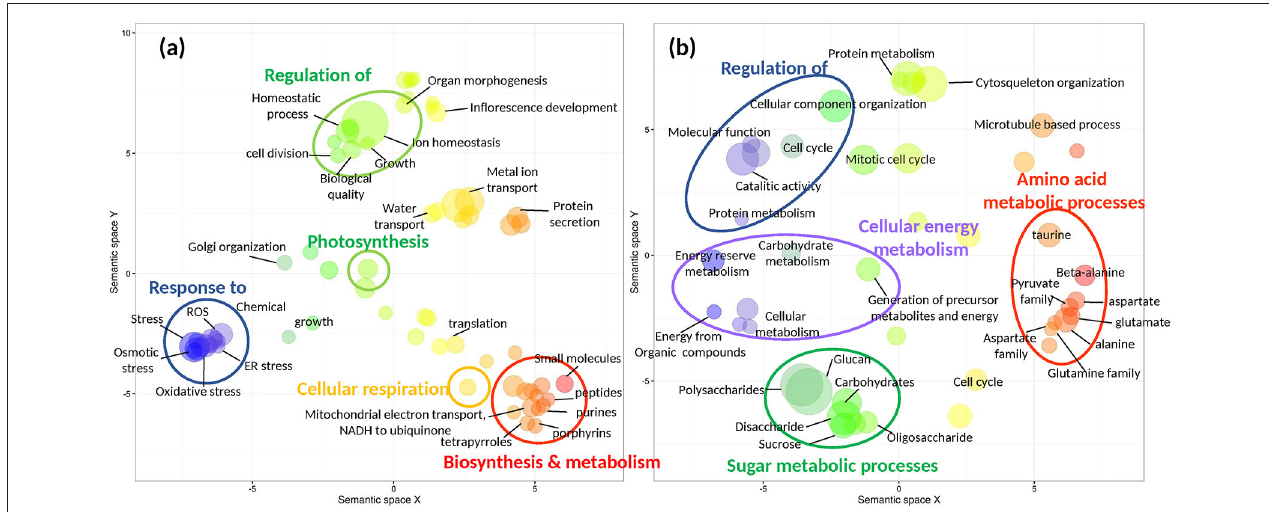
FIGURE 4 | Functional enrichment (Fisher test, false discovery rate < 0.001) of heat-responsive shallow-unique (a) and deep-unique (b) s-DEGs ( > 4 FC, FDR < 0.001). Gene ontology (GO) terms of biological processes are represented by bubbles and plotted according to semantic similarities to other GO terms. Bubble size is proportional to log 10 p -values of the GO term, while color indicates semantic similarities. The two-dimensional semantic space was generated by the REVIGO web service with all GO terms found in the enrichment analyses. REVIGO’s tables containing all gene functional categories represented in (a) and (b) are given as supplementary information (Data S3A and